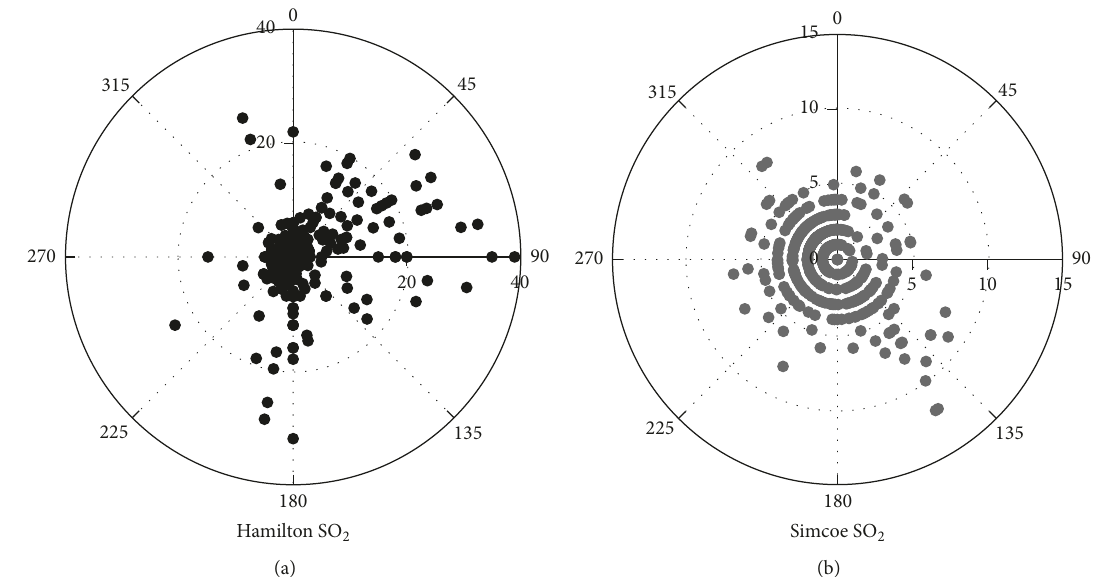
Figure 6: Polar plot of hourly averaged SO 2 mixing ratios at (a) Hamilton and (b) Simcoe. Radial axis shown is in